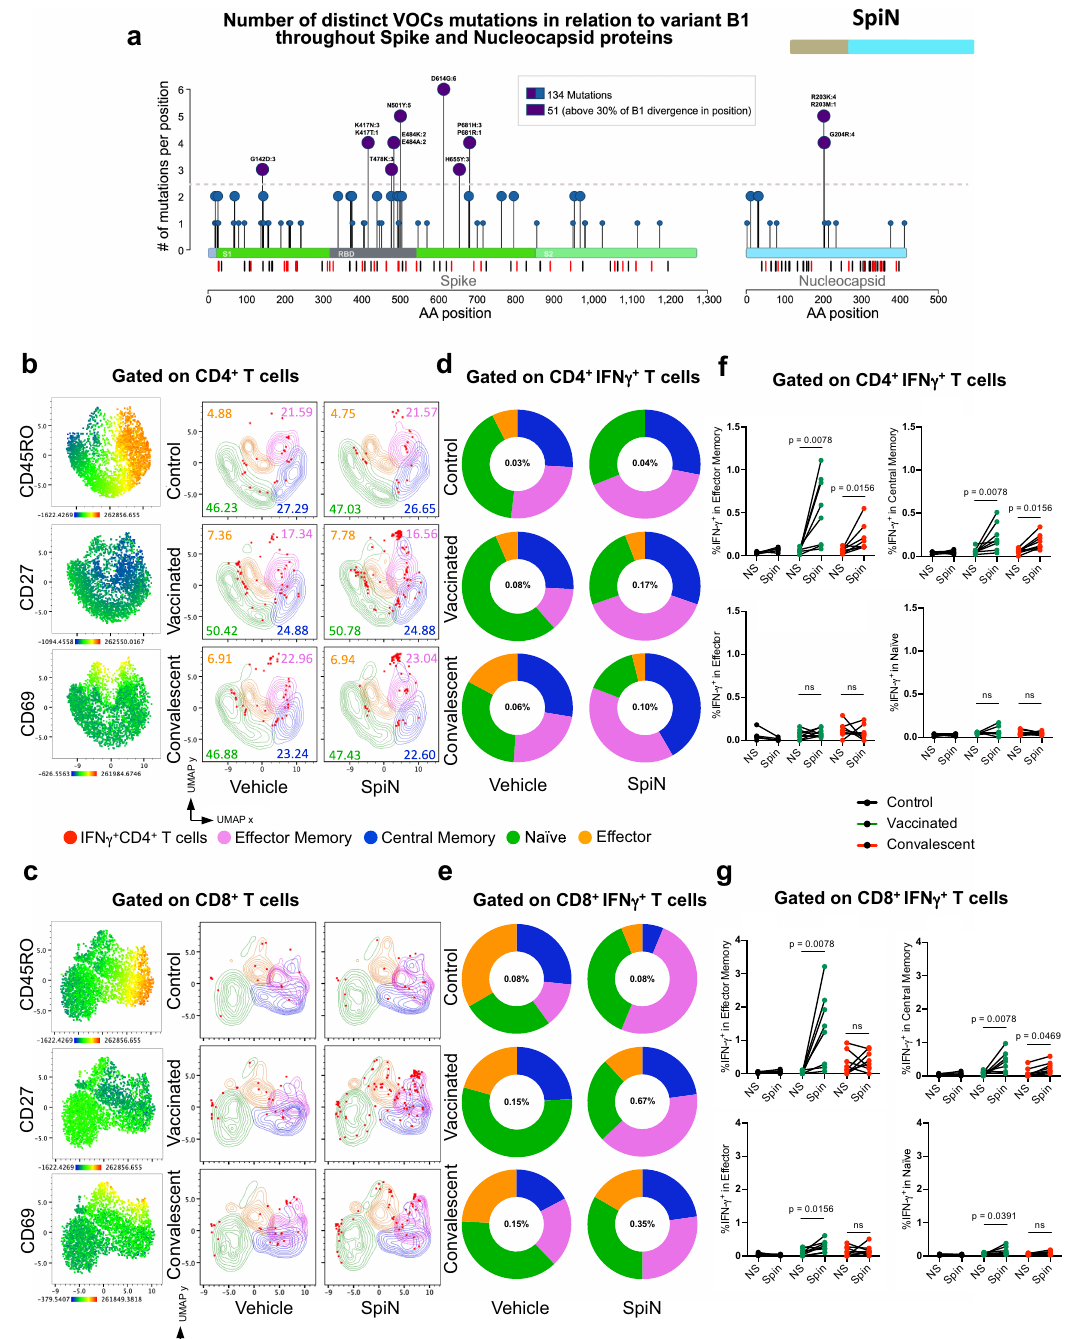
Fig. 1 | Human antibody and IFN γ responses to N and RBD polypeptides. a Needleplotindicatingthenumberofaminoaciddivergencepointsintheprotein sequenceofNucleocapsid(N)andSpike(S)of fi vevariantsinrelationtotheNandS sequencesfromtheSARS-CoV-2lineageB(Wuhan).Thepeakswithcirclesindicate the position of the most frequent amino acid changes. The height of the peaks indicatesthefrequencyofthechangesineachdivergentpoint.Theblueandpurple circles indicate common mutations and those observed on variants of concern, respectively.Thesumoftheaminoacidchangesforeachsegment(S1,RBD,andS2) of the S and N proteins considering the 6 SARS-CoV2 lineages is also shown. The vertical black and red lines below the bars illustrating the N and S polypeptides